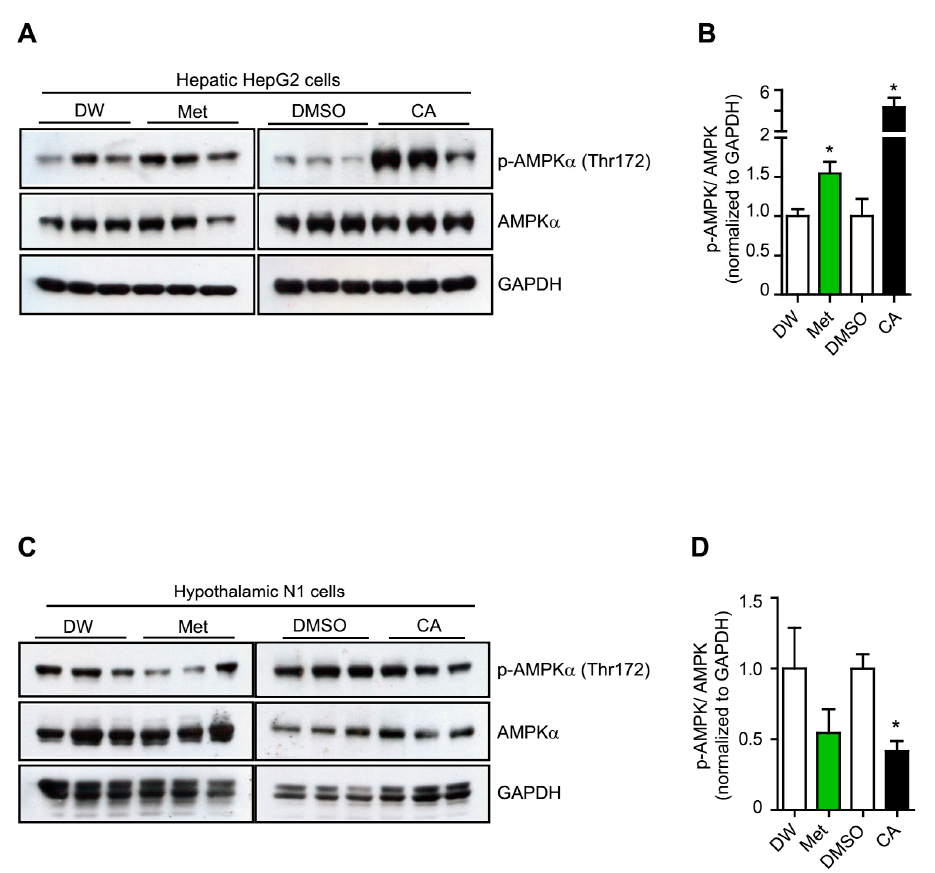
Figure 1. Different effects of CA treatment on AMPK activation in hepatic HepG2 cells and hypothalamic N1 cells. Immunoblots ( A ) and graph ( B ) showing effects of CA and metformin (met) treatments on AMPK activation in the hepatic HepG2 cells. Immunoblots ( C ) and graph ( D ) showing effects of CA and metformin treatments on AMPK activation in the hypothalamic N1 cells. The results are expressed as mean ± SEM. Two-tail Student’s t -test. * p < 0.05. DW: distilled water.